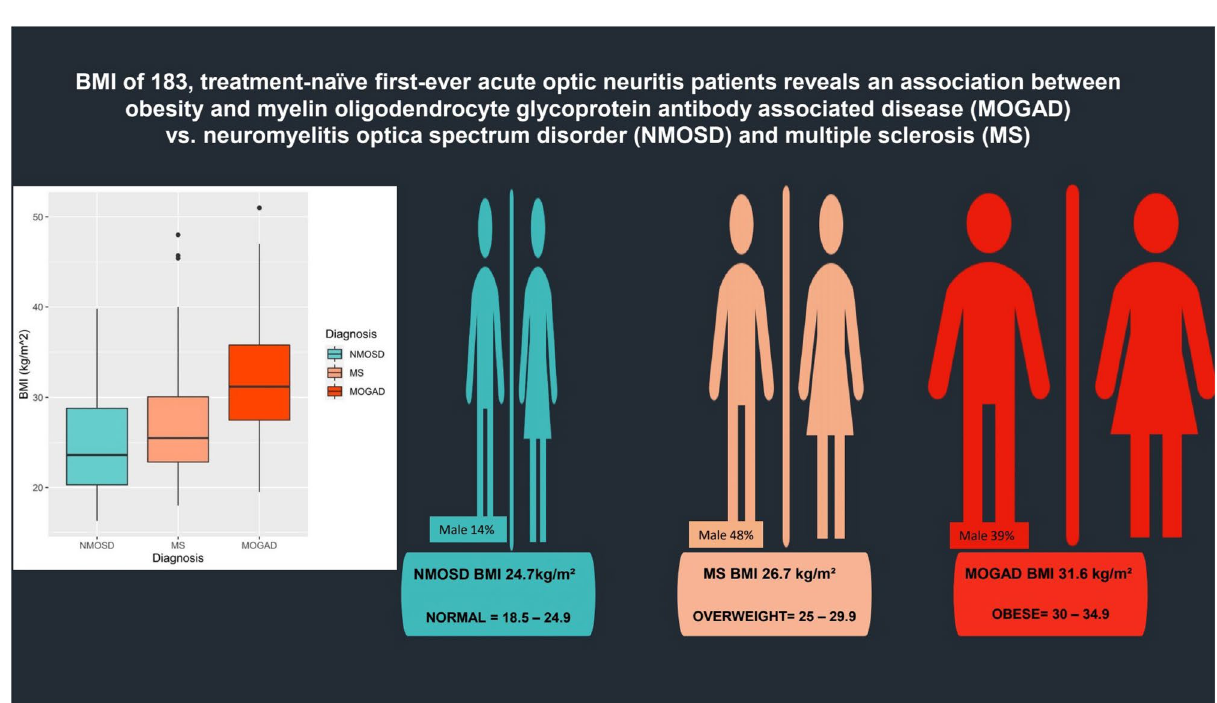
Figure 2. Infographic of body mass index (BMI) at presentation of first-ever acute optic neuritis in patients with myelin oligodendrocyte glycoprotein antibody-associated disease (MOGAD), neuromyelitis optica spectrum disorder (NMOSD), and multiple sclerosis (MS). Legends: Plots demonstrating the distribution of BMI by group. The boxplot lines correspond to the 25th, 50th and 75th percentiles. The male symbol represents the percentage of male patients in each